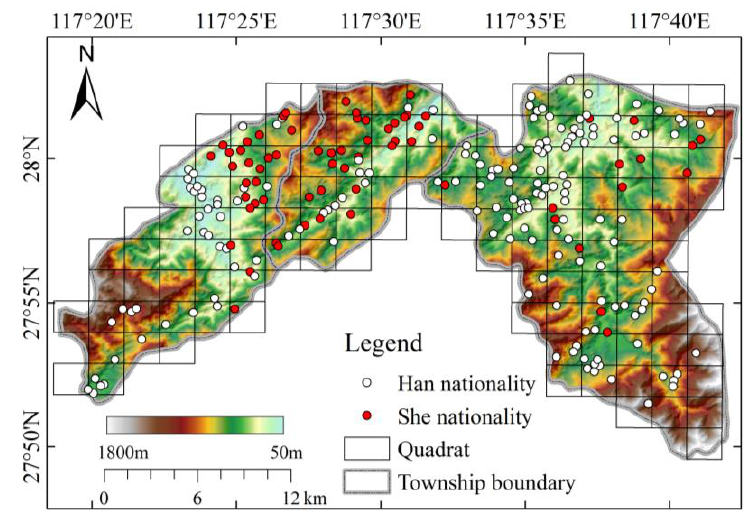
Figure 4. Quadrat distribution in study area.